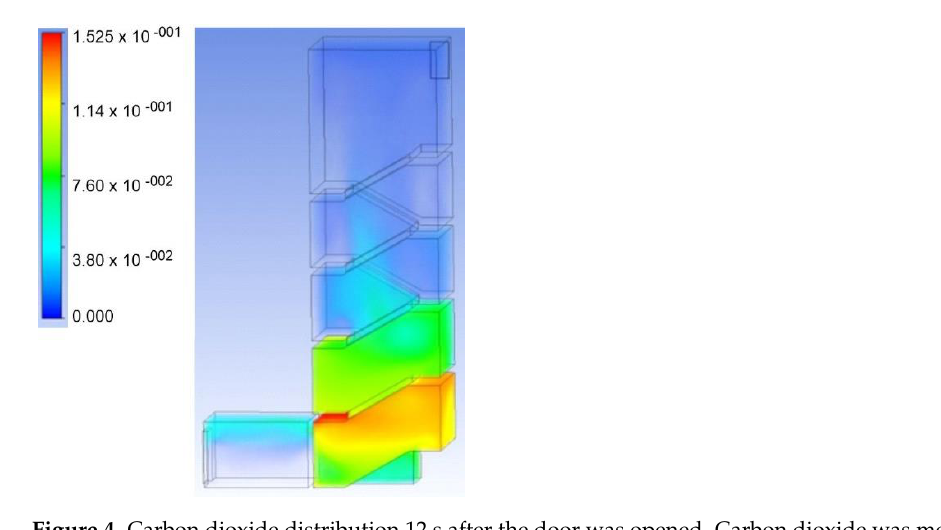
Figure 4. Carbon dioxide distribution 12 s after the door was opened. Carbon dioxide was measured as a mass fraction.